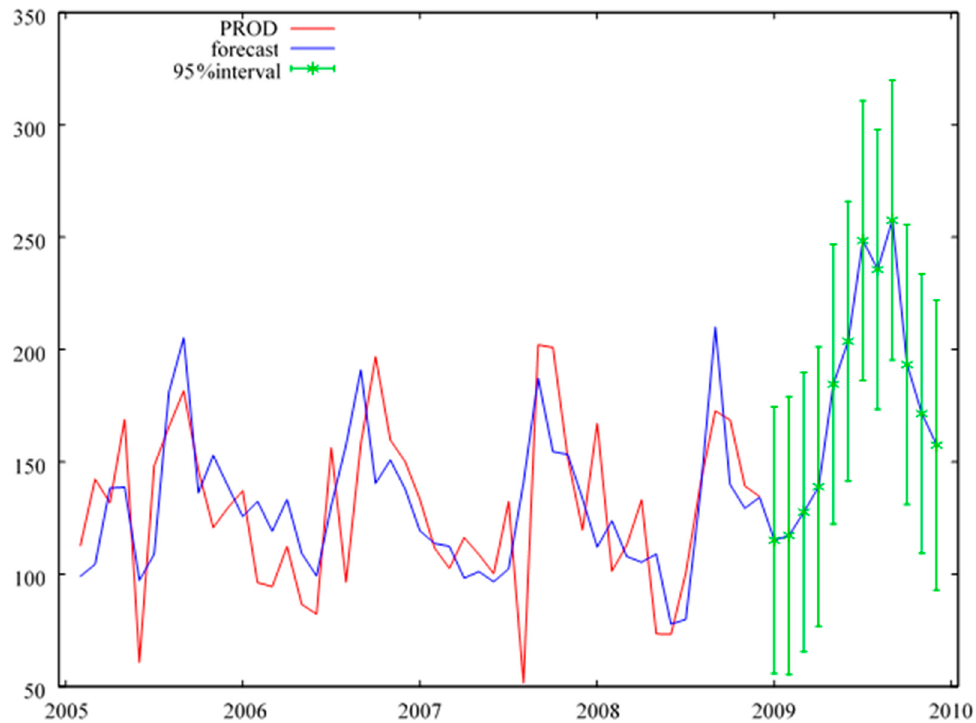
( s ) PROD for the year 2009, in a system with an increase in the for the year 2009, in a system with an increase in the PROD for the year 2009, in a system with an increase in the Tp Tp Tp